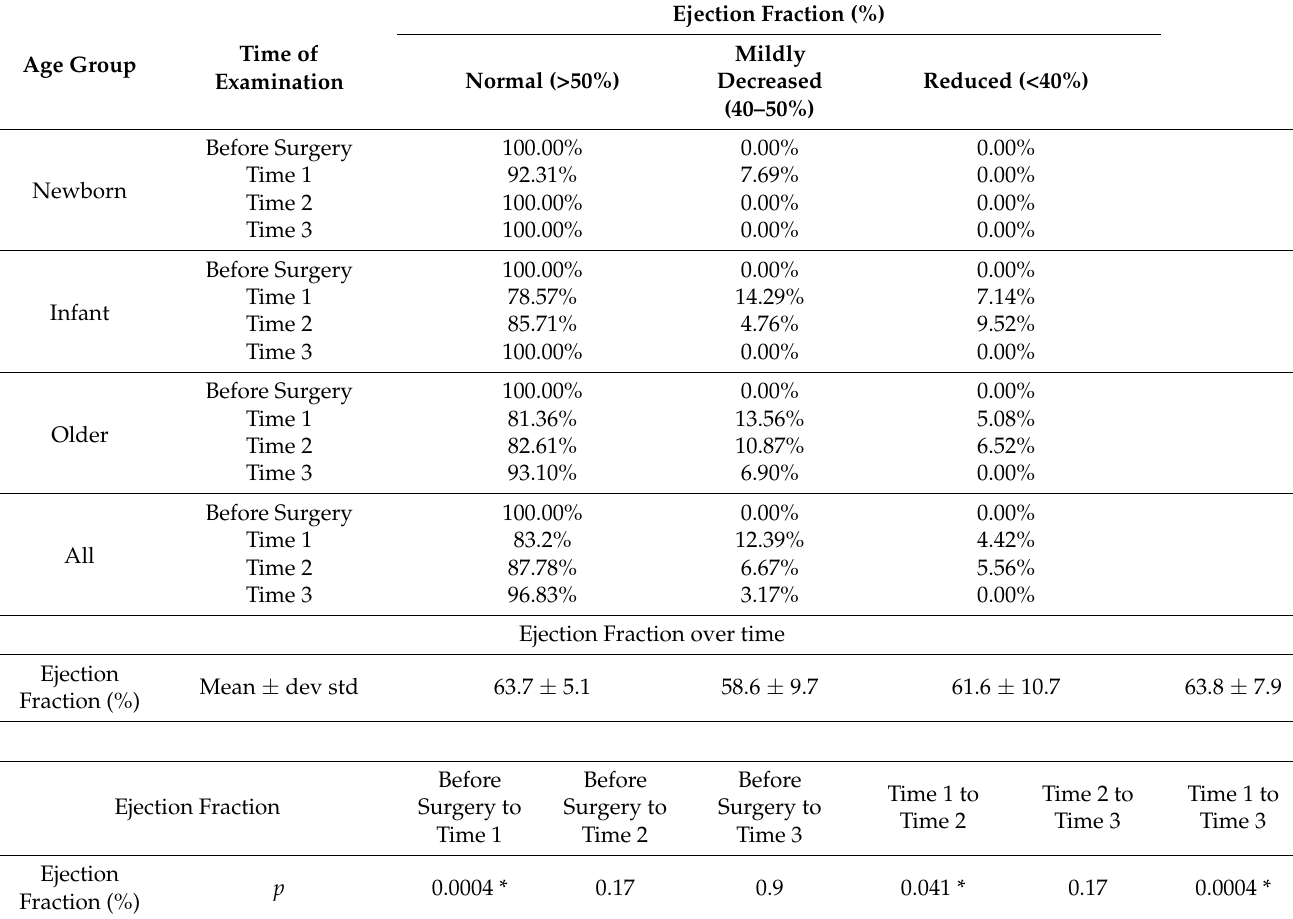
Table 6. Time trend of postoperative LV ejection fraction